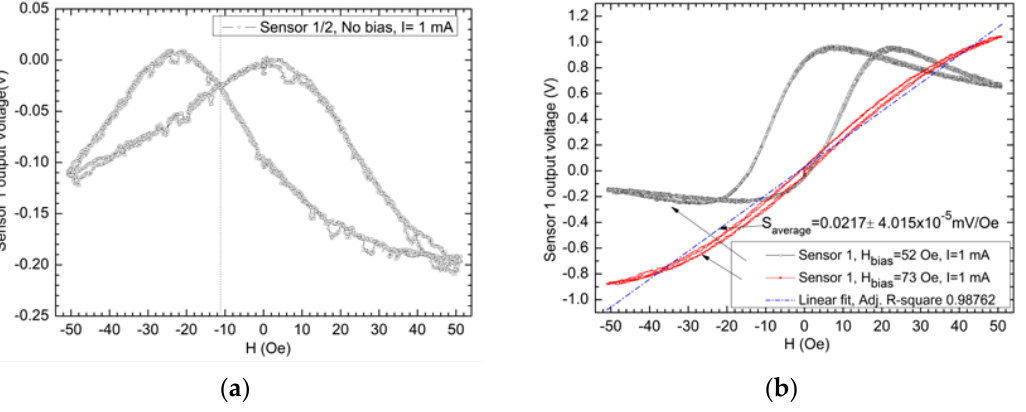
Figure 14. Thermally annealed AMR bridge sensor, field characteristics: ( a ) No applied biasing field; ( b ) Field characteristics for different H bias values.